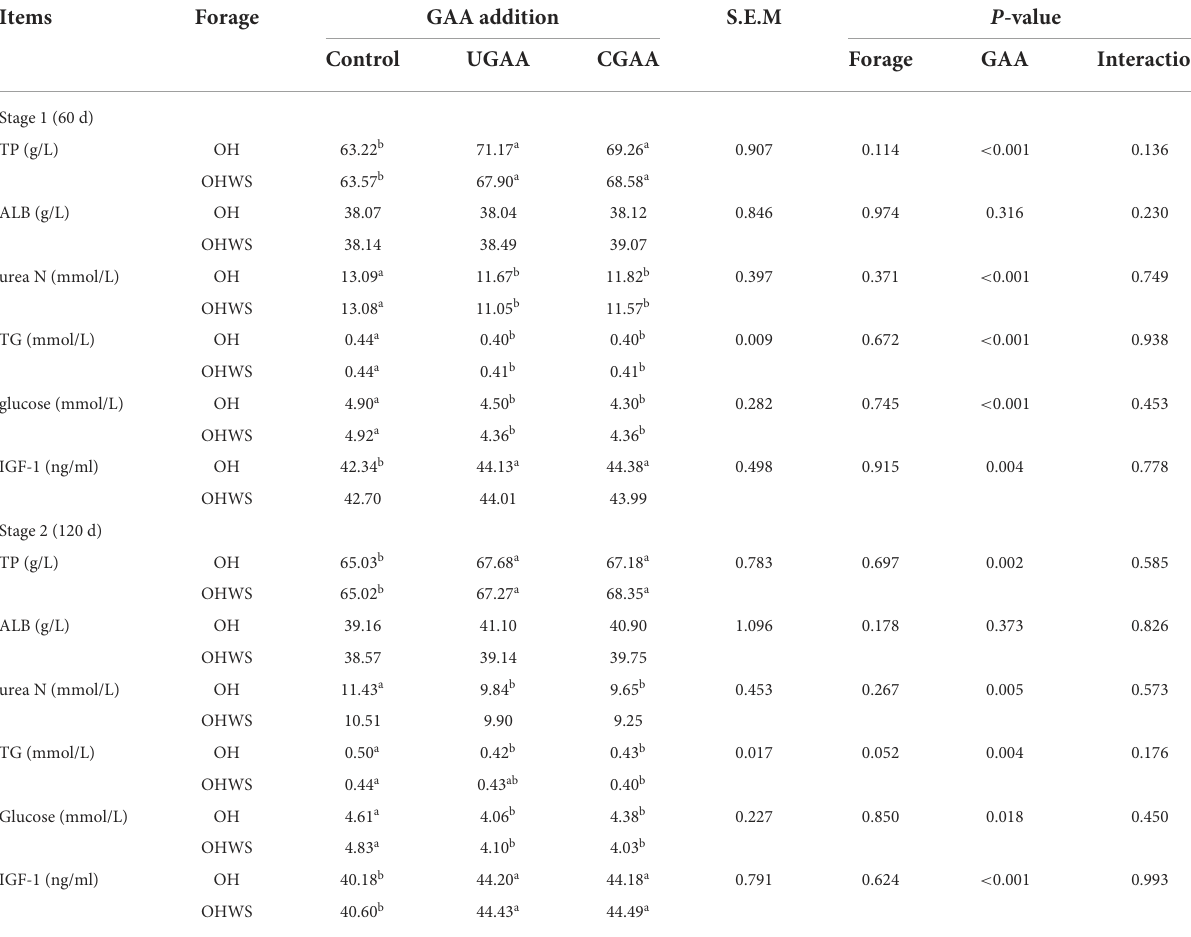
TABLE 5 Effects of forage type and guanidine acetic acid (GAA) addition on blood metabolites in feedlotting lambs at different feeding stages (stage 1, 60 day; stage 2, 120 day).